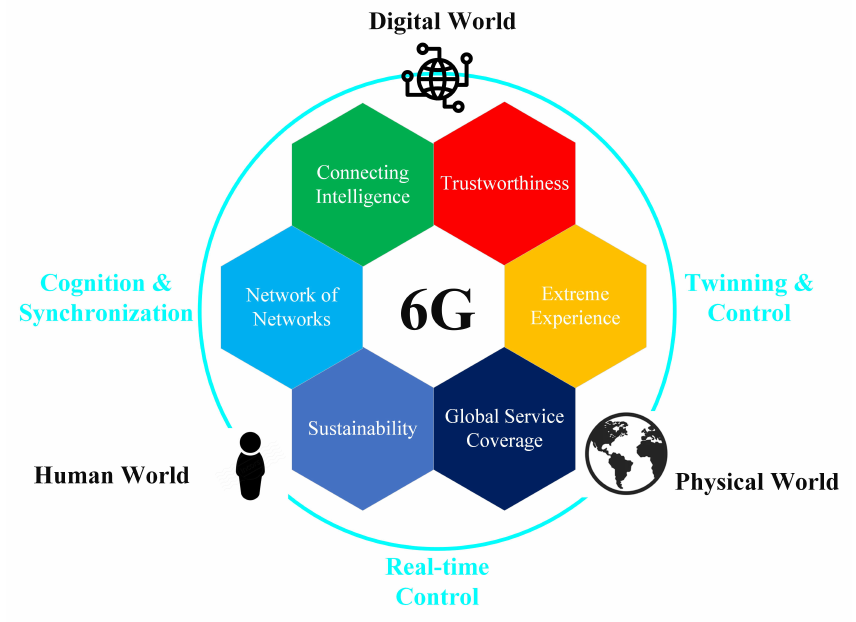
Figure 1. The 6G